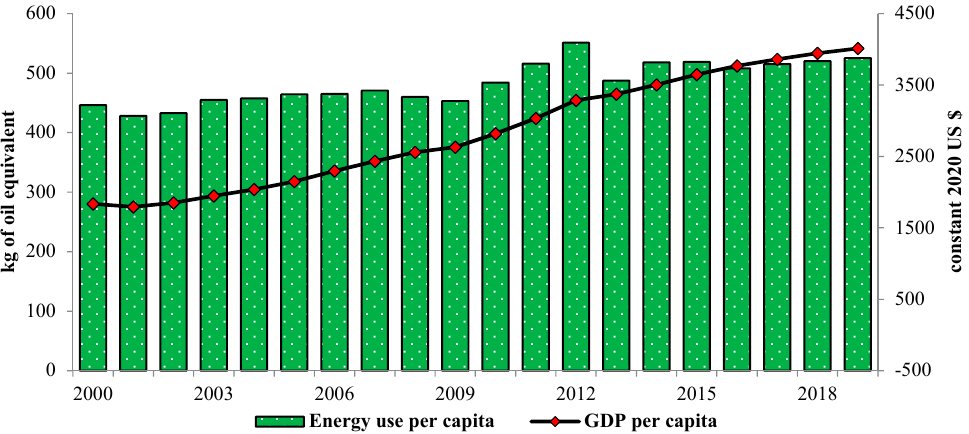
Figure 2. The real GDP per capita and energy use per capita trends in Sri Lanka. Note: Energy use per capita ( left axis ); Real GDP per capita ( right axis ). Source: World Development Indicators [21].